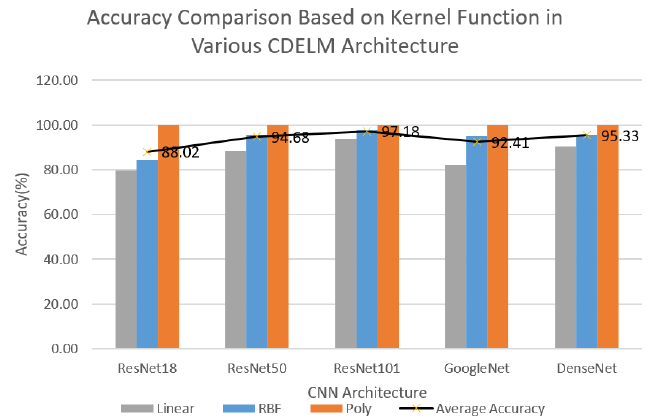
Figure 12. Results of Experiment on the 4 class DRIVE Dataset.